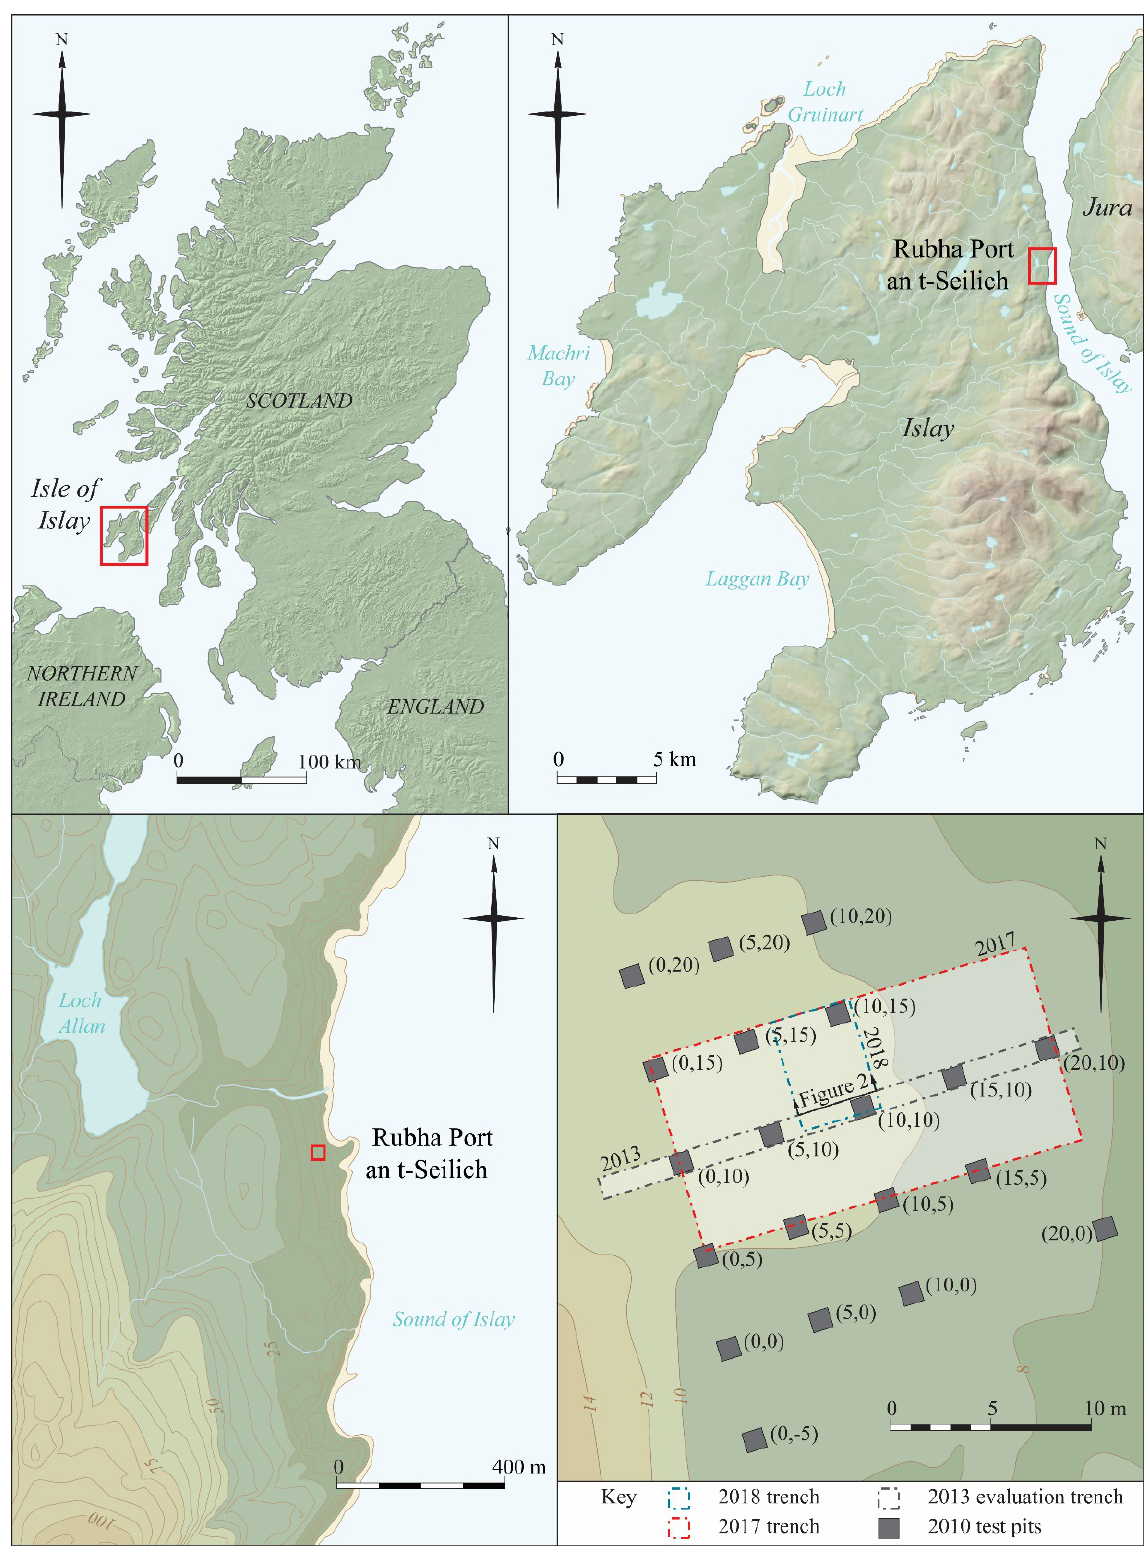
Figure 1. Location map of RPAS, showing the trial trench excavation of 2013, and location of 2010 test-pits, 2013 and 2017 trenches. Contains Ordnance Survey data and database rights 2019 Ordnance Survey (100025252). (Jamieson